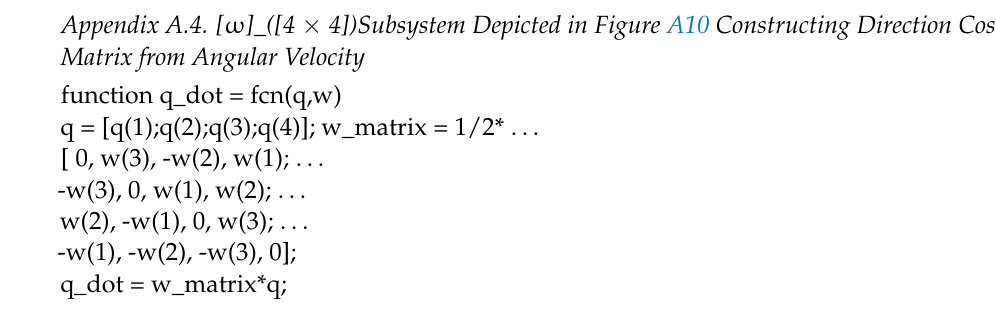
Figure A10. Quaternion Calc subsystem depicted in Figure A1.